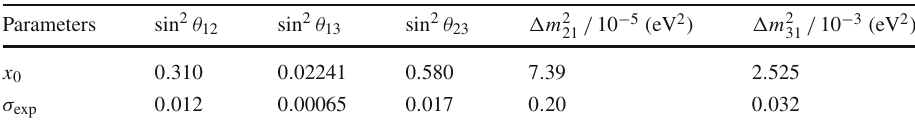
Table 1 Neutrino data used in the sampling of the μν SSM for the anomalous magnetic moment of the muon